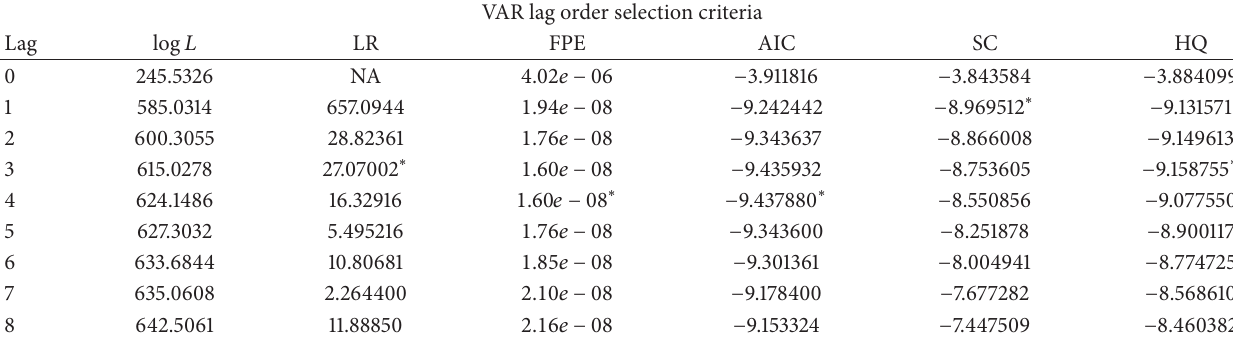
Table 4: VAR lag order selection criteria. VAR lag order selection criteria